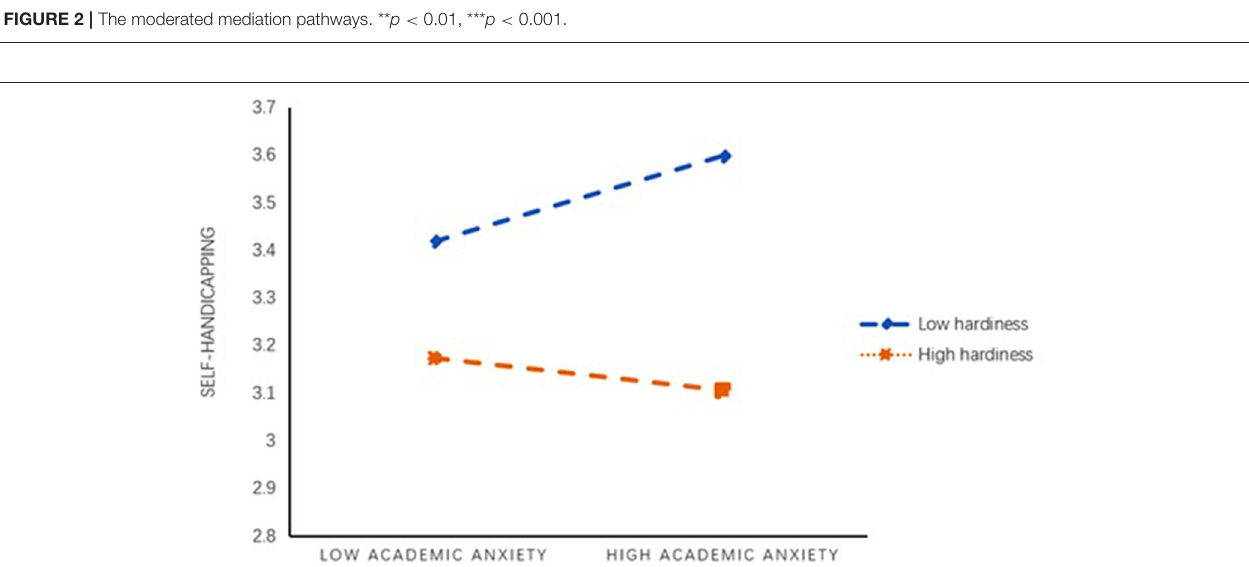
FIGURE 3 | Hardiness moderates the relationship between academic anxiety and